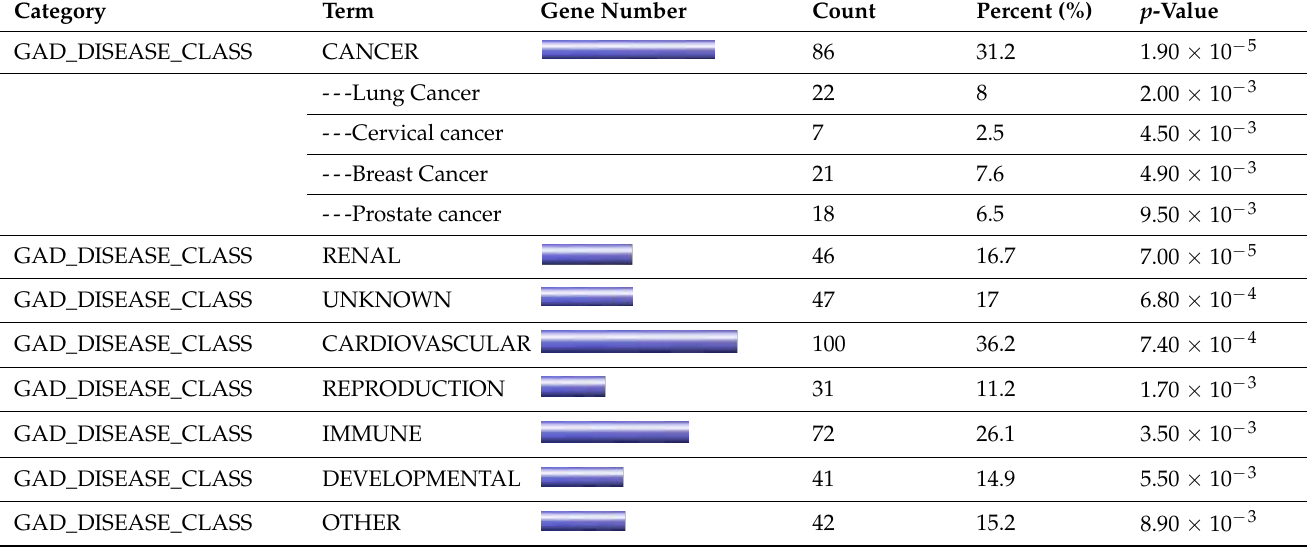
Table 1. Functional enrichment analysis of DEGs by DAVID.